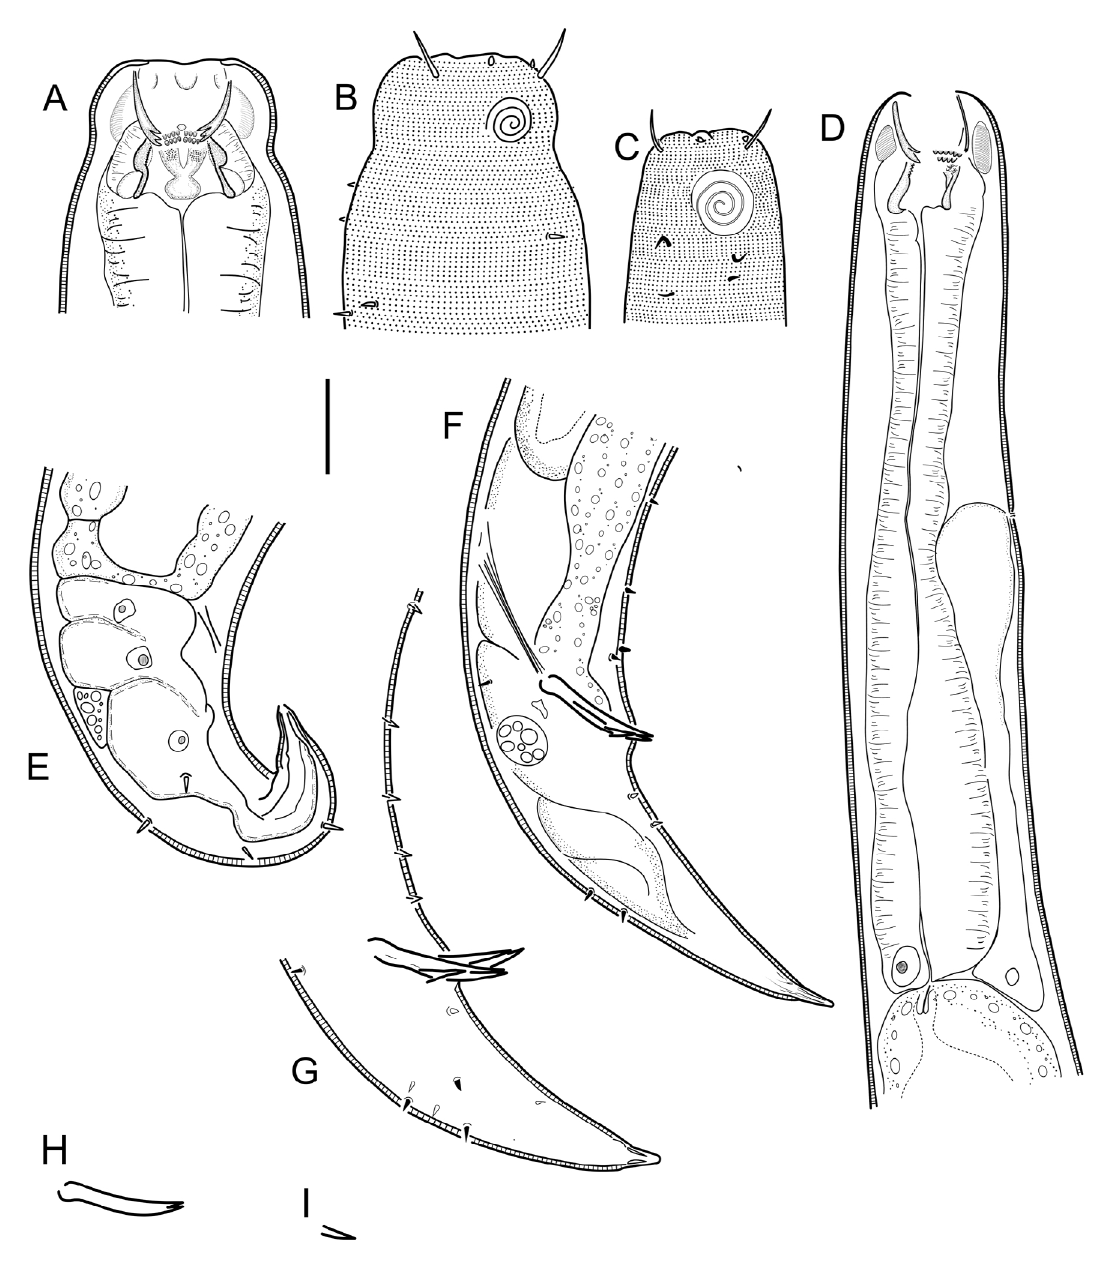
Fig. 6. Cobbionema brevispicula sp. nov. A . Female head region (ventral side to the right) (SMNH- 182041). B . Surface view of female head (ventral side to the right) (SMNH-182041). C . Surface view of the male holotype head (ventral side to the right) (SMNH Type-9219). D . Anterior part of male holotype (ventral side to the right) (SMNH Type-9219). E . Female caudal region (SMNH-182041). F–G . Male holotype caudal region (SMNH Type-9219). H . Spicule. I . Crura. Scale bar = 20